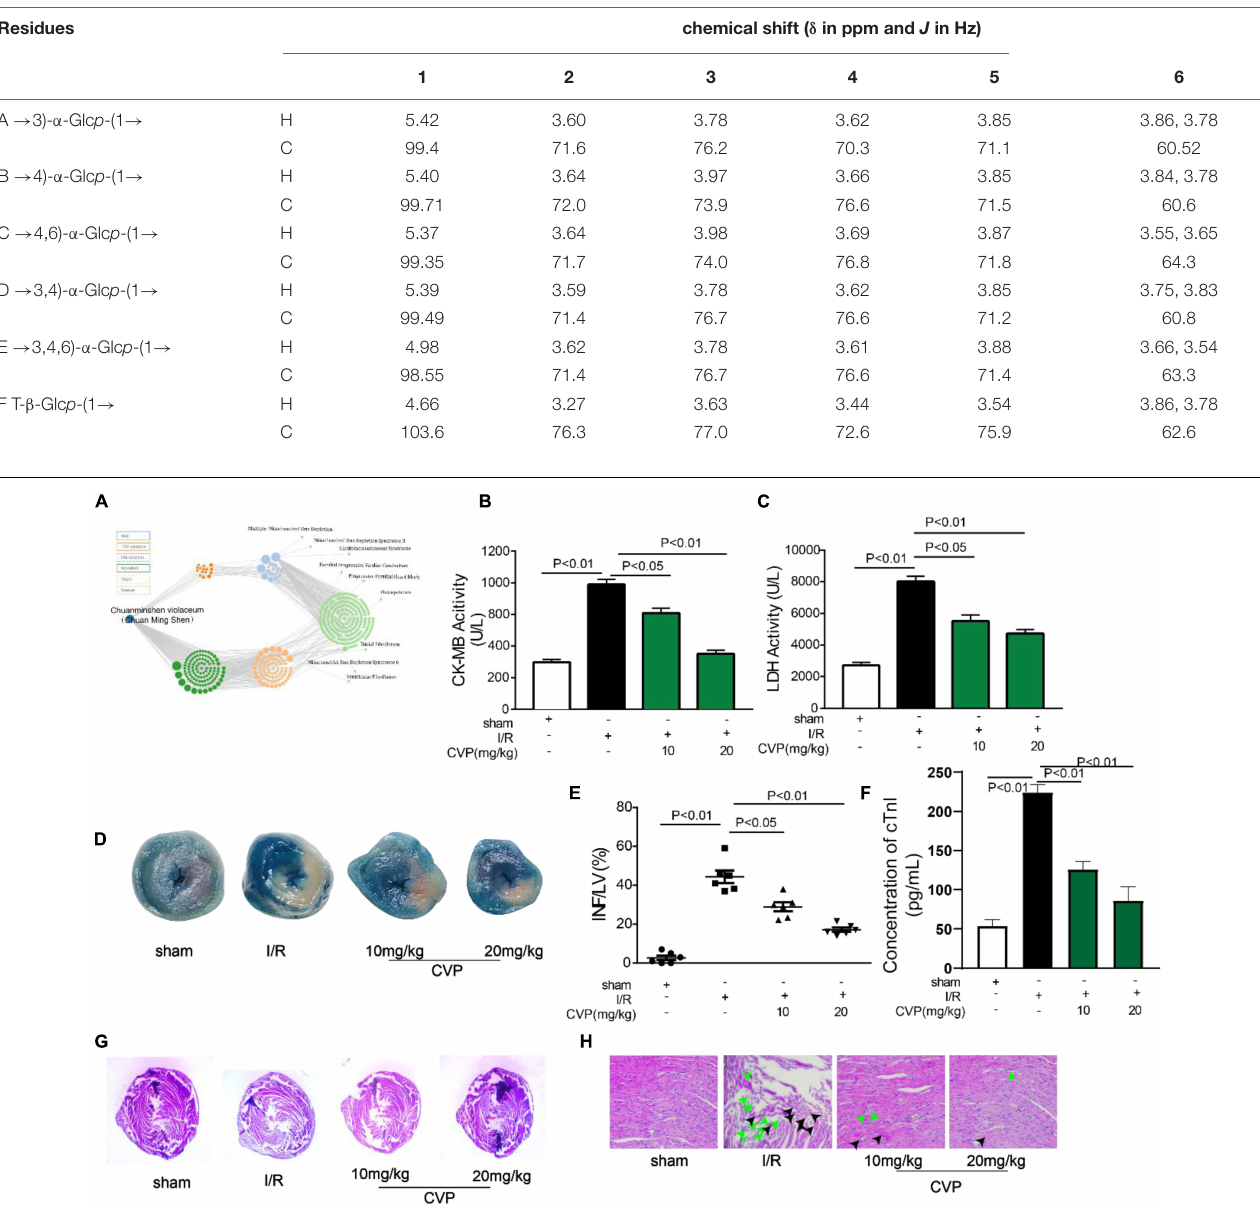
FIGURE 3 | The protective effect of CVP on I/R injury in mice. Results of network pharmacology analysis of Chuanminshen violaceum (A) ; mice were exposed to 45 min ischemia and 24 h reperfusion to construct the I/R model. Then serum levels of CK-MB (B) , LDH (C) , and cTnI (F) were measured with biochemical test kits; after hearts were separated, infarct size was estimated by TTC and Evans blue doubling-staining, blue represents normal tissue, red represents ischemic but non-infarcted areas, and white represents ischemic and infarcted areas (D) ; infarct size was quantized using computerized planimetry (E) ; morphological changes of myocardium (G) and myocardial cells (H) were observed by H&E staining, the green arrow represents damaged myocardial cells and the black arrow represents myocardial edema. cTnI, cardiac troponin I; CVP, Chuanminshen violaceumis polysaccharides; INF, infarction; I/R, ischemia-reperfusion; LDH, lactate dehydrogenase; LV, left